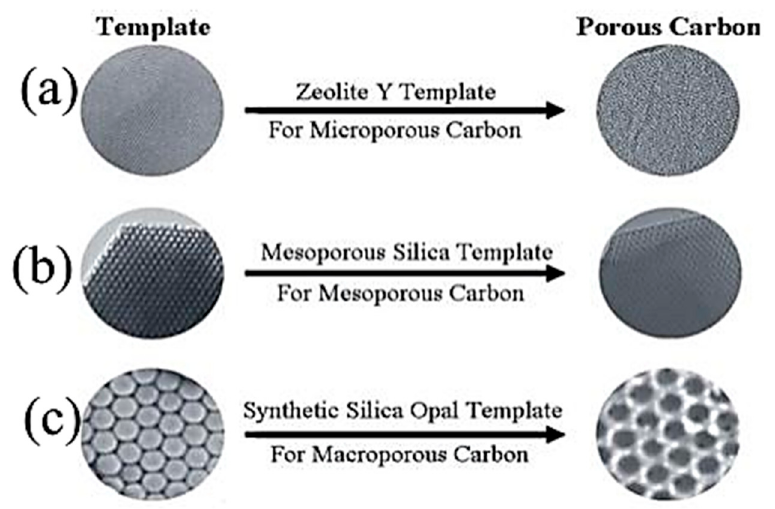
Figure 4. ( a ) Microporous, ( b ) mesoporous, and ( c ) macroporous carbon materials were synthesized using zeolite, mesoporous silica, a synthetic silica opal, respectively [58].